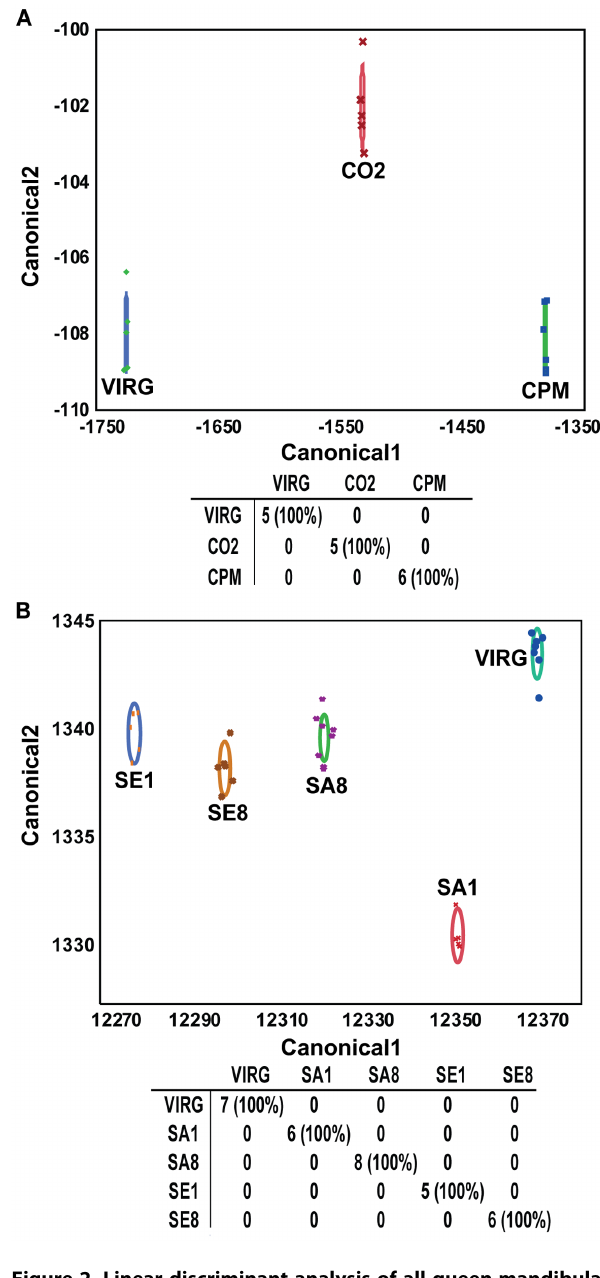
Figure 2. Linear discriminant analysis of all queen mandibular gland pheromone components. The relative proportions of the individual compounds found in the mandibular glands of the queens in experiments 1 and 2 were arcsine square root transformed and subjected to linear discriminant analysis. A ) Discriminant plot with classification of Virg, CO 2 and CPM queen groups based on 27 compounds and the table of actual (rows) by predicted (columns) numbers of queens in different groups. Symbols represent individual queens; ellipse represents the 95% confidence region containing the true mean. B ) Discriminant plot with classification of Virg, SA1, SA8, SE1, and SE8 queen groups based on 28 compounds and the table of actual (rows) by predicted (columns) numbers of queens in the different groups. Numbers in parentheses represent the percentage of queens classified